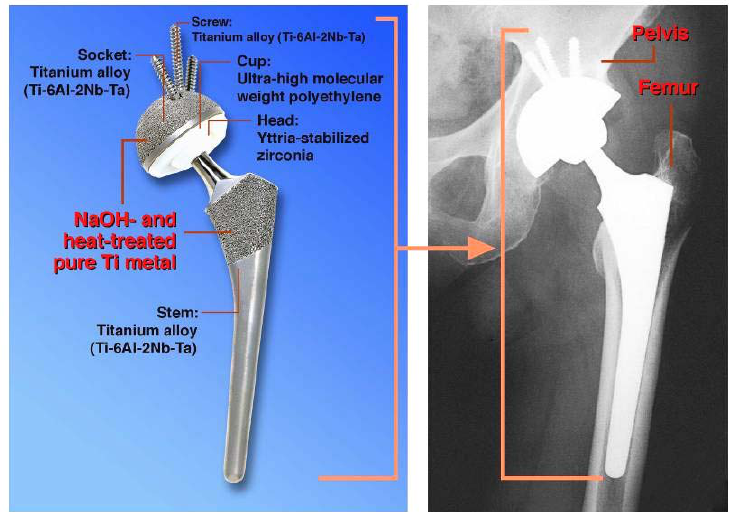
Figure 13. Clinical application of NaOH- and heat-treated Ti metal in hip joint